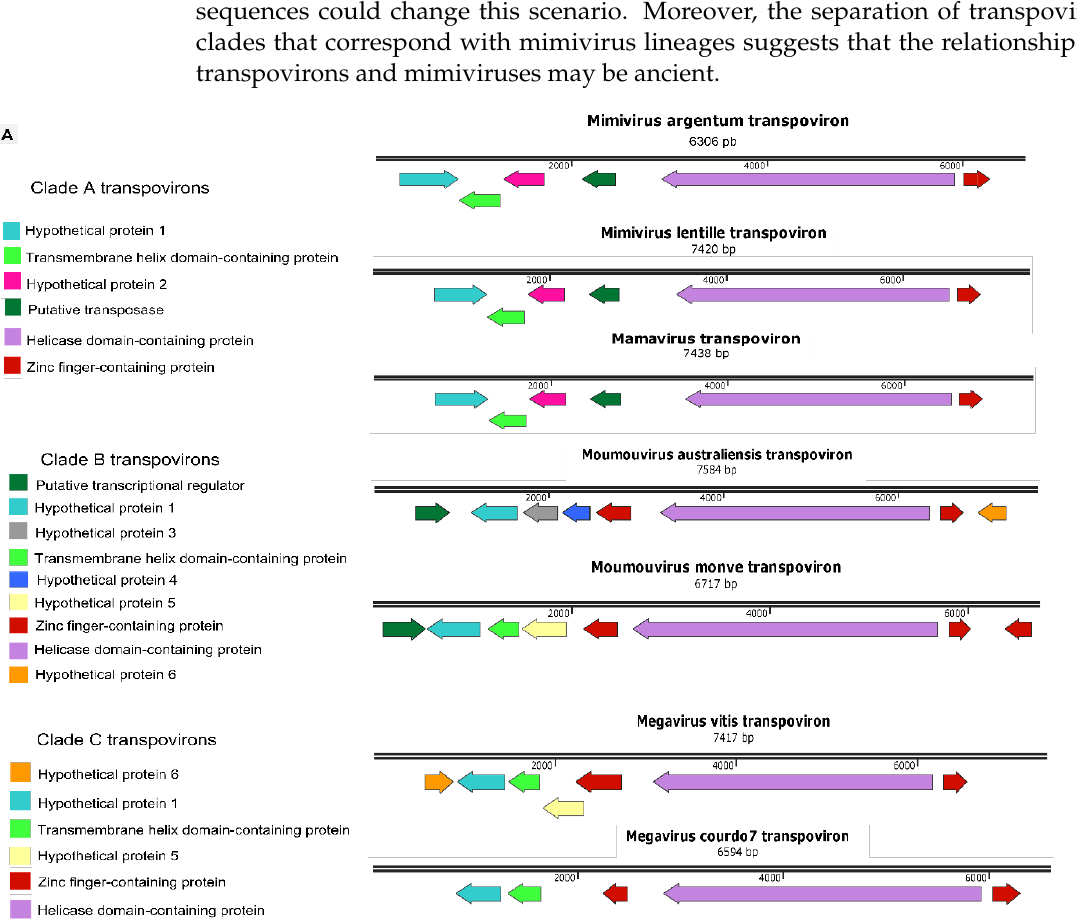
Figure 5. Genomic comparison between known transpoviron sequences. ( A ) Individual maps of the seven known transpovirons. Colored arrows indicate the ORFs distribution throughout genomes. Homolog ORFs are represented by the same color, and each predicted function is indicated in the color legend. Right-directed arrows represent positive strand ORFs and left-directed arrows repre- sent negative strand ORFs. ( B ) Venn diagram summarizing the transpovirons proteins occurrence in each of the three clades (A, B and C). Note: megavirus courdo7 transpoviron is described to